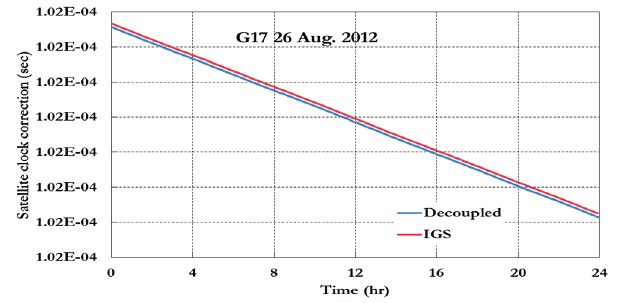
Figure 3. IGS and decoupled clock corrections 26 August 2012.